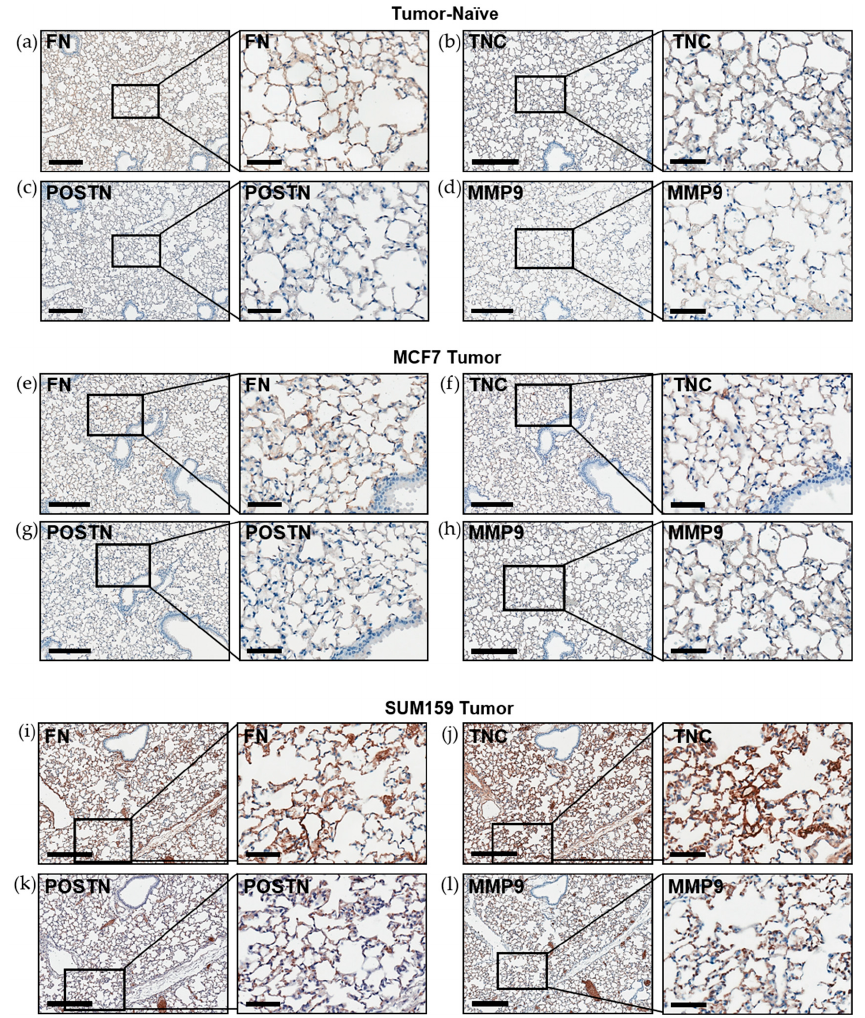
Figure 3. Expression of the premetastatic niche markers fibronectin, tenascin-c, periostin and MMP9